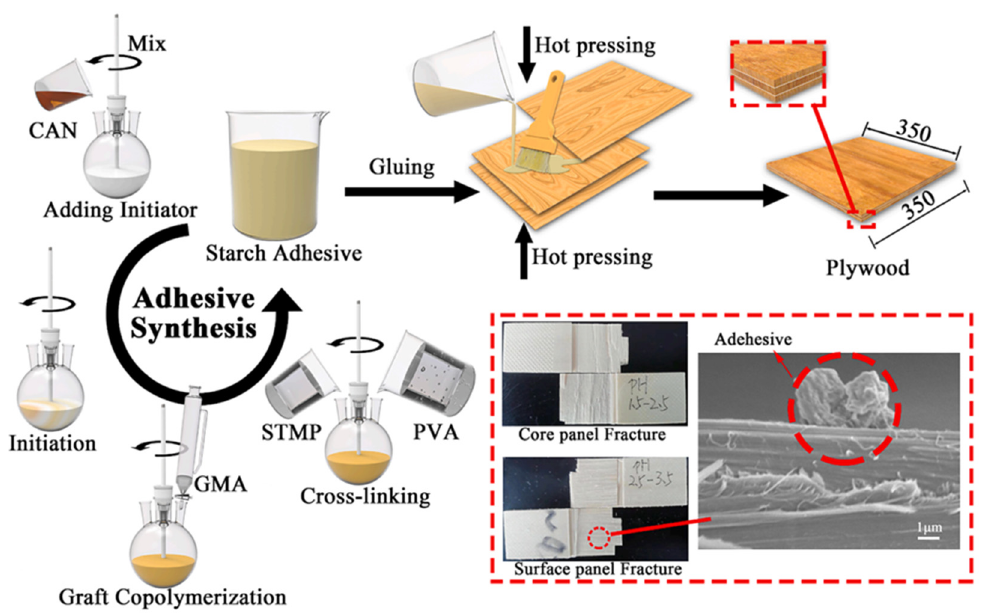
Figure 9. Starch-based adhesive synthesis and plywood preparation [140]. Reprinted/adapted with permission from Ref. [140]. 2022, Elsevier, License Number 5400560927363.